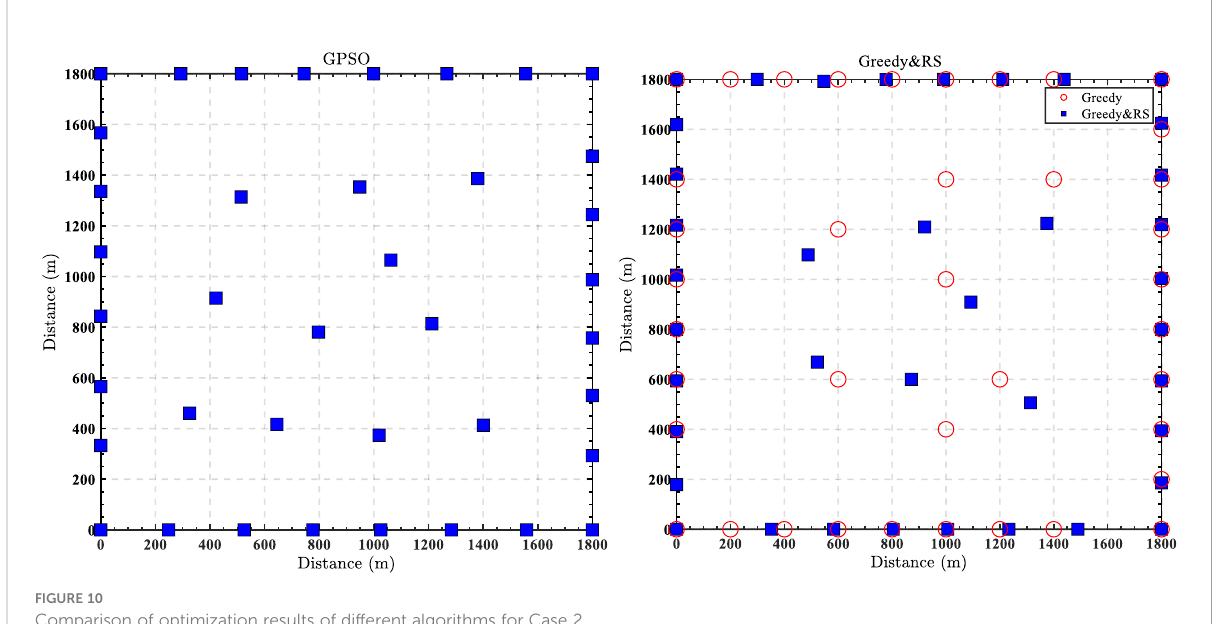
FIGURE 10 Comparison of optimization results of different algorithms for Case